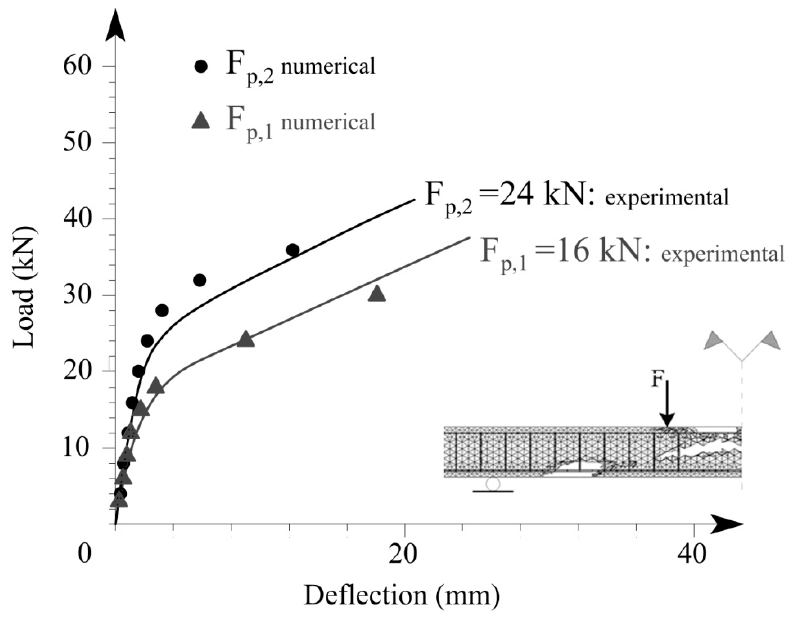
Figure 6. Load-deflection responses for various levels of pre-tensioning: pre-tensioning force equal to 11 kN (grey) and pre-tensioning force equal to 17 kN (black). Results obtained by finite element analysis are compared with experimental results.